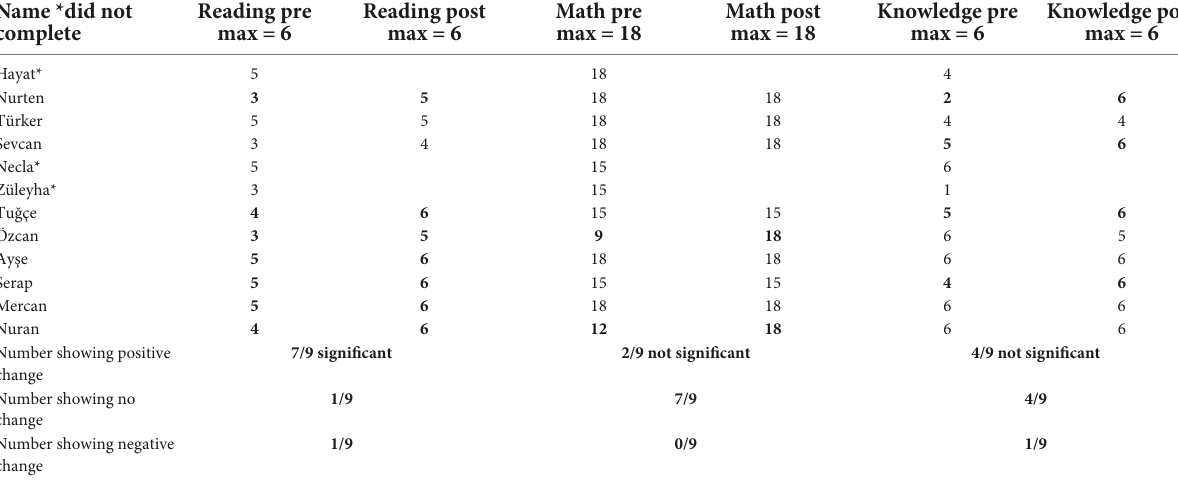
TABLE 1 Mean scores on literacy, math and general knowledge pre- and post-tests. Name *did not complete